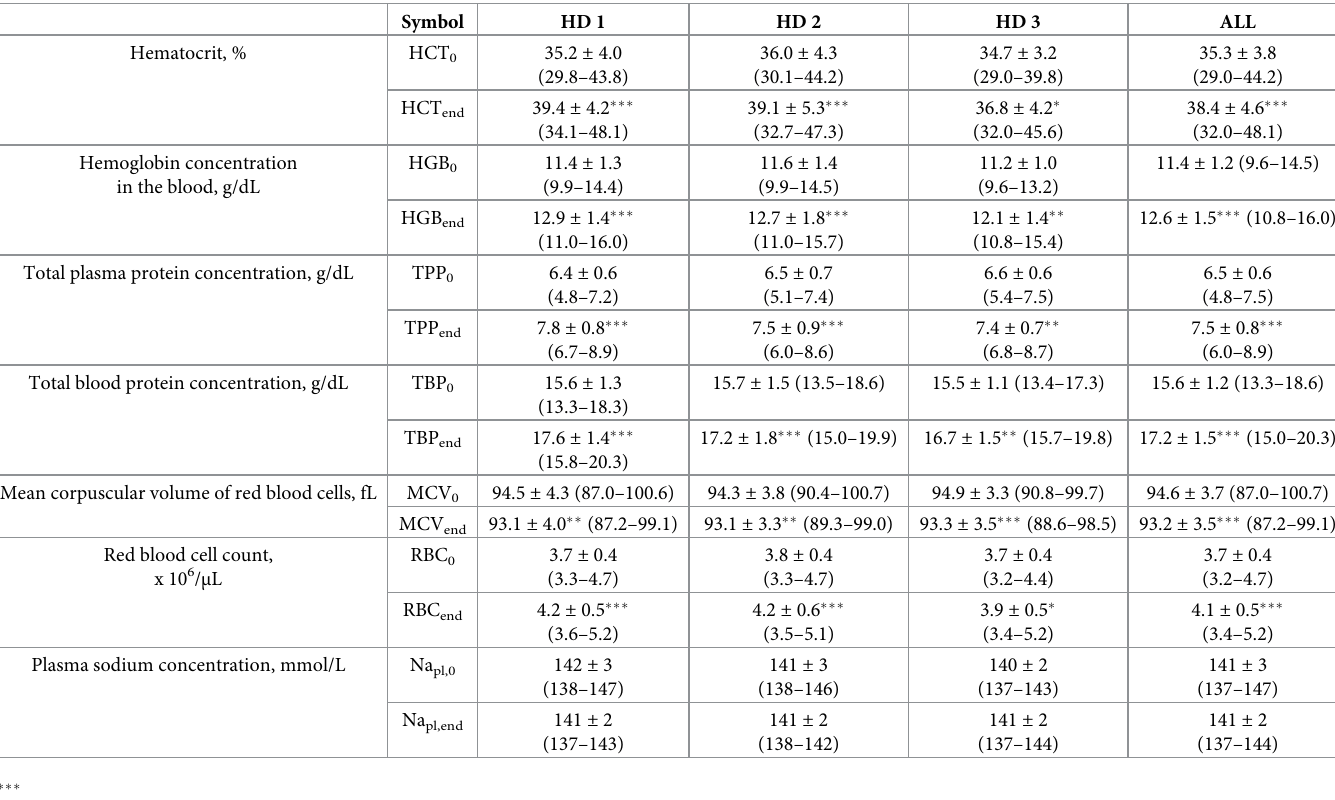
Table 3. Blood parameters measured in the studied patients at the beginning (subscript 0) and at the completion (subscript end) of first (HD 1), second (HD 2), third (HD 3) and all HD sessions. All data presented as mean ± SD (range). Symbol HD 1 HD 2 HD 3 ALL Hematocrit,